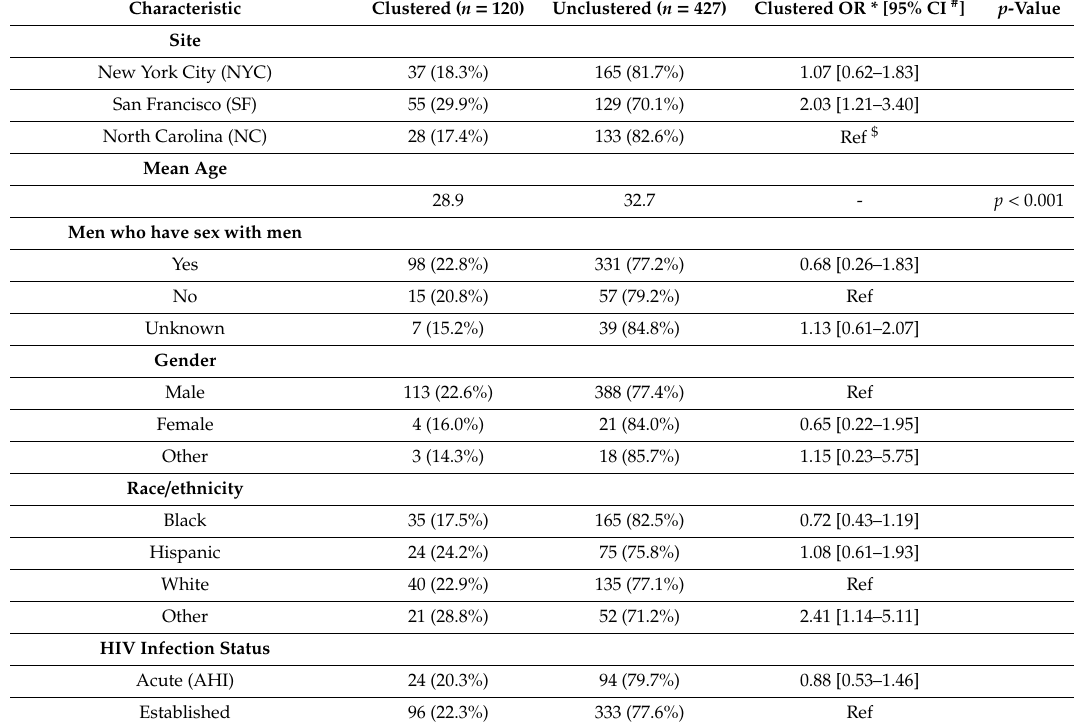
Table 1. Demographic characteristics of clustered and unclustered HIV sequences in NYC, SF and